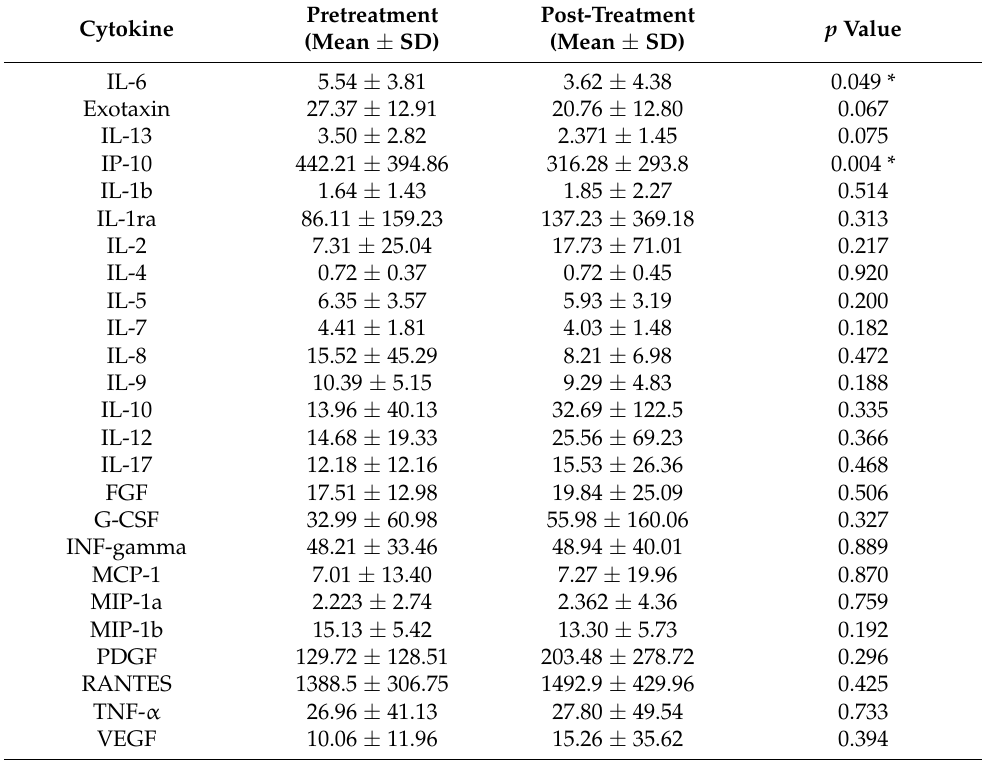
Table 2. Baseline cytokine and post-treatment cytokine status of MRgFUS thermal ablation for bone metastasis.